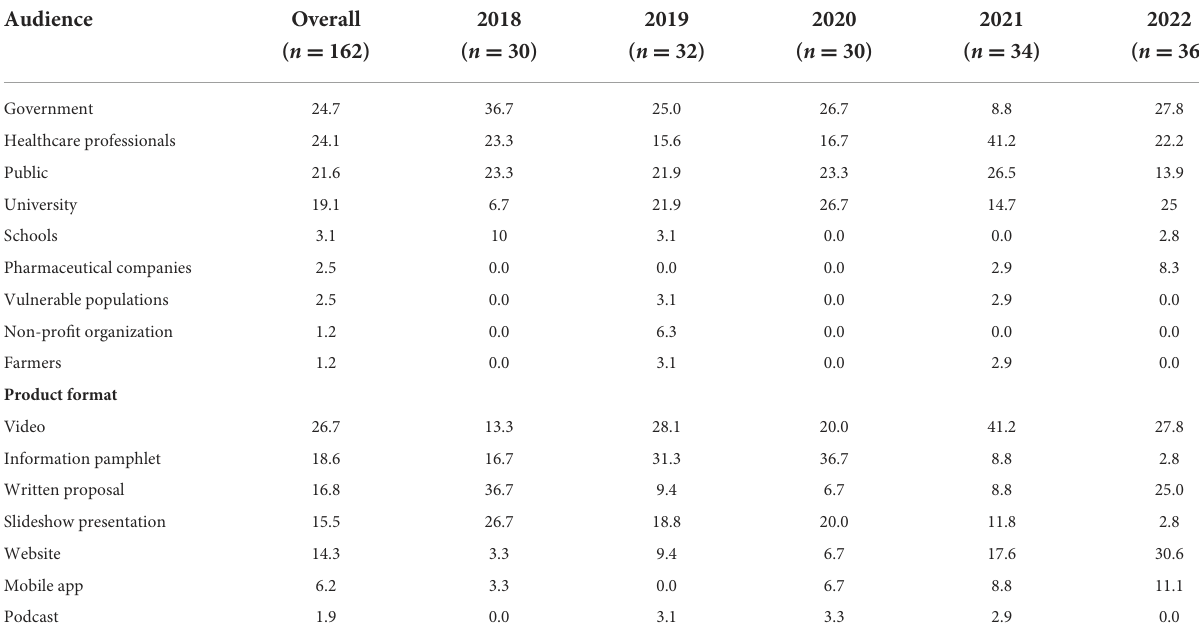
TABLE 1 Intended audience and product format for the five-year period